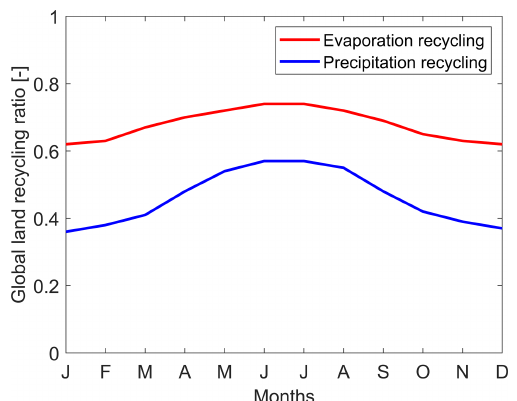
Figure 3. Monthly variability of evaporation (red) and precipitation (blue) global land recycling ratios. Evaporation recycling ratio is the fraction of evaporation that subsequently rains down over land. Precipitation recycling ratio is the fraction of precipitation that has evaporated from